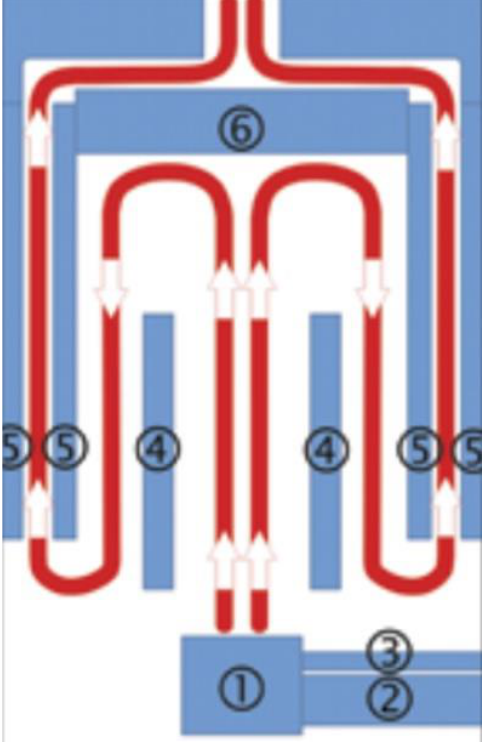
Figure 1. Elements of the used biomass boiler’s combustion chamber and flue gas flow: 1—burner, 2 — pellet feeder, 3 — aeration pipe, 4 — partition, 5 — water jacket, 6 — exhaust deflector.